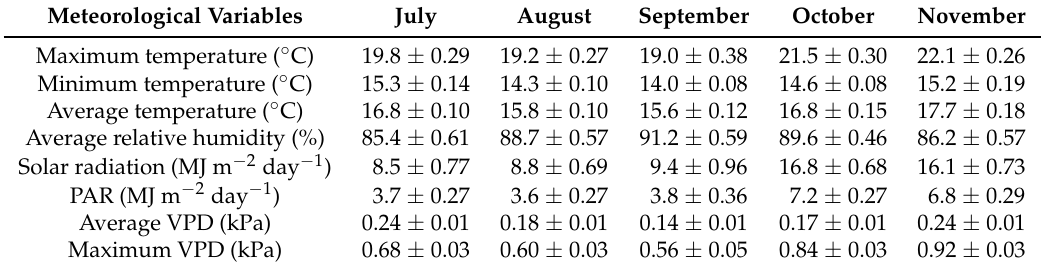
Table 6. Average daily values ( ± SE) of environmental conditions during the experimental growing season 2017. PAR—Photosynthetically active radiation. VPD—Vapor pressure deficit.